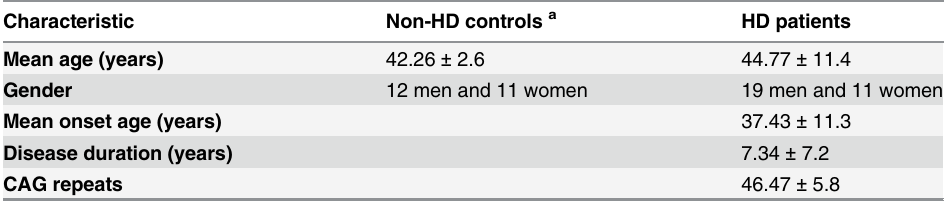
Table 1. Clinical characteristics of Huntington ’ s disease (HD) patients.